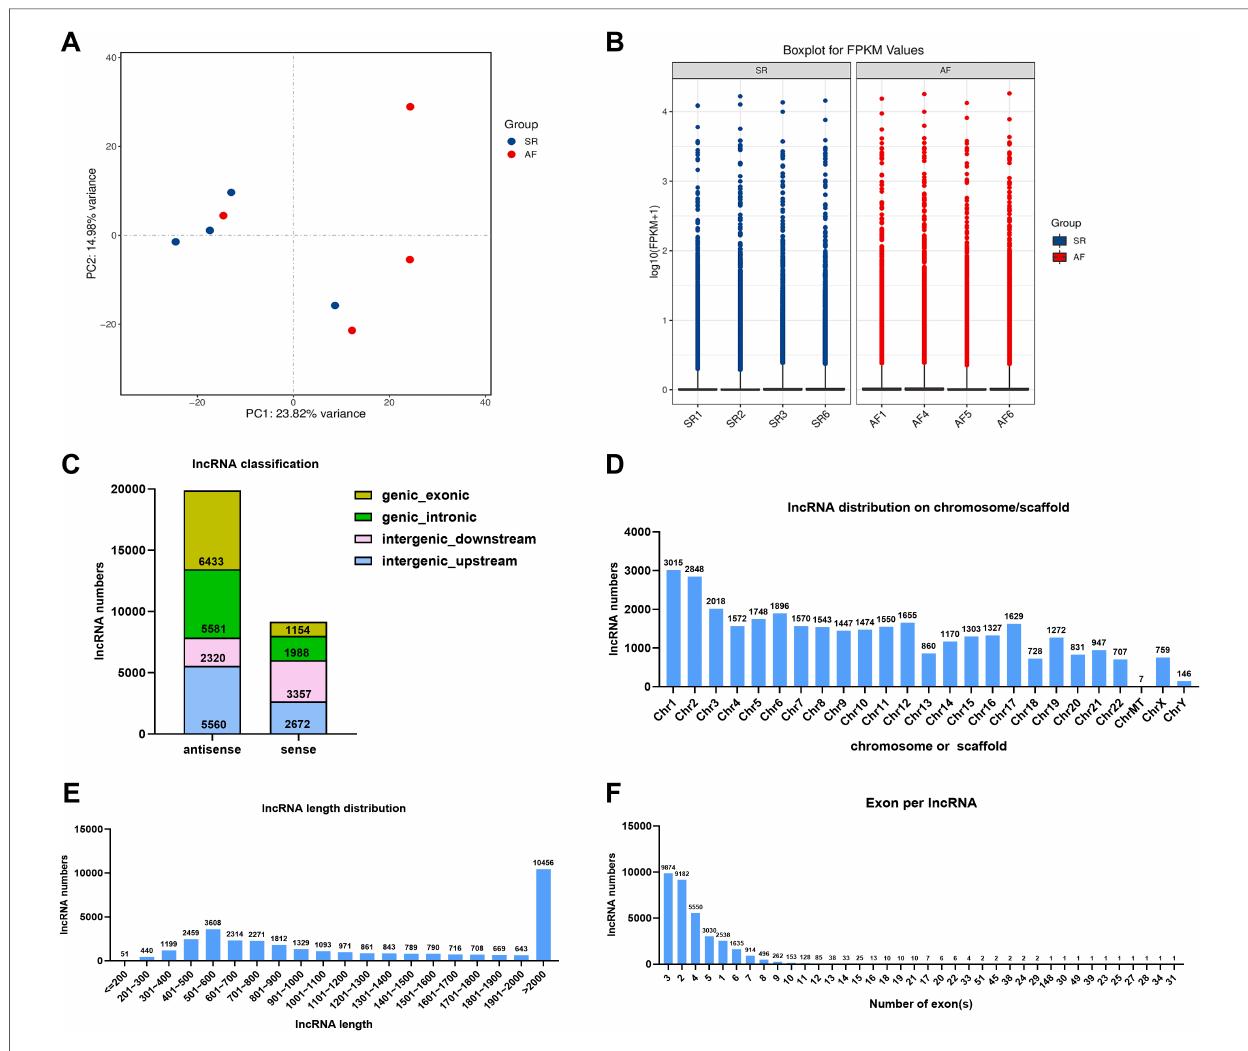
FIGURE 3 Transcriptome sequencing analysis of DE lncRNAs in the SR and AF groups. ( A ) Principal component analysis (PCA) of SR and AF patient samples. ( B ) Boxplot for FPKM values of lncRNAs in each sample. ( C ) Percentage of different types of lncRNAs. ( D ) Chromosomal distribution of the lncRNAs. ( E ) LncRNA lengths in the two groups. ( F ) Statistical diagram of lncRNA exon